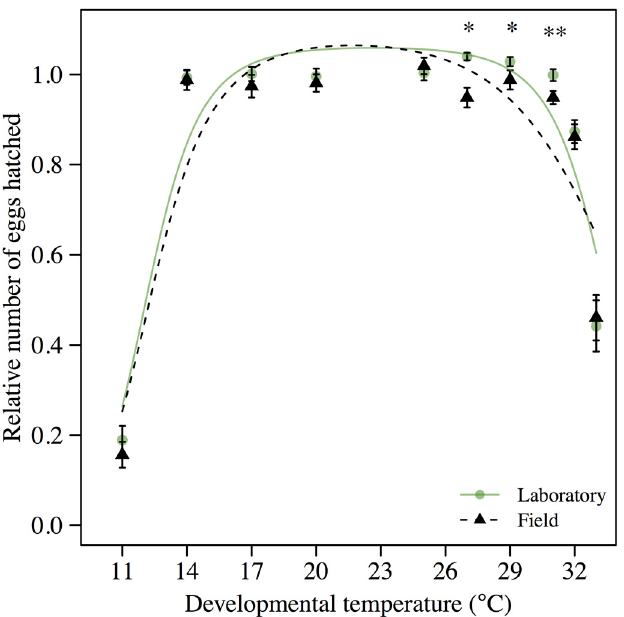
Fig 3. Egg-to-adult viability across developmental temperatures. Mean egg-to-adult viability ± s.e. for field and laboratory reared flies across a range of constant developmental temperatures. We assessed egg- to-adult viability with laboratory flies after three generations in the laboratory and with freshly collected field flies. The performance curves obtained from the logistic regression are represented with a solid and a punctuated line for laboratory and field flies, respectively. The performance curves, as well as the plotted values, are standardized to the average performance at 20 and 25°C within each treatment. * P < 0.05, ** P <